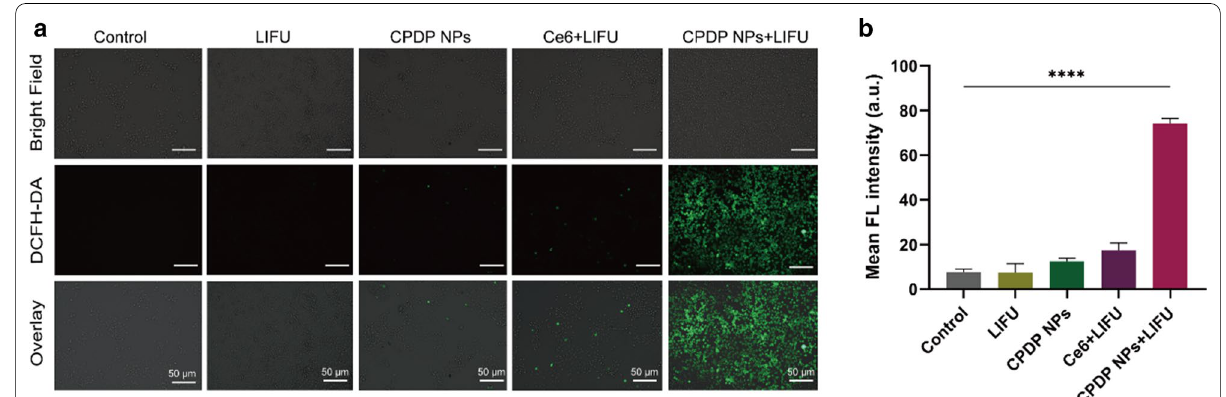
Fig. 4 a CLSM images of ROS generation with various treatments and b the corresponding FL intensity analysis (**** p < 0.0001, n bars are 50